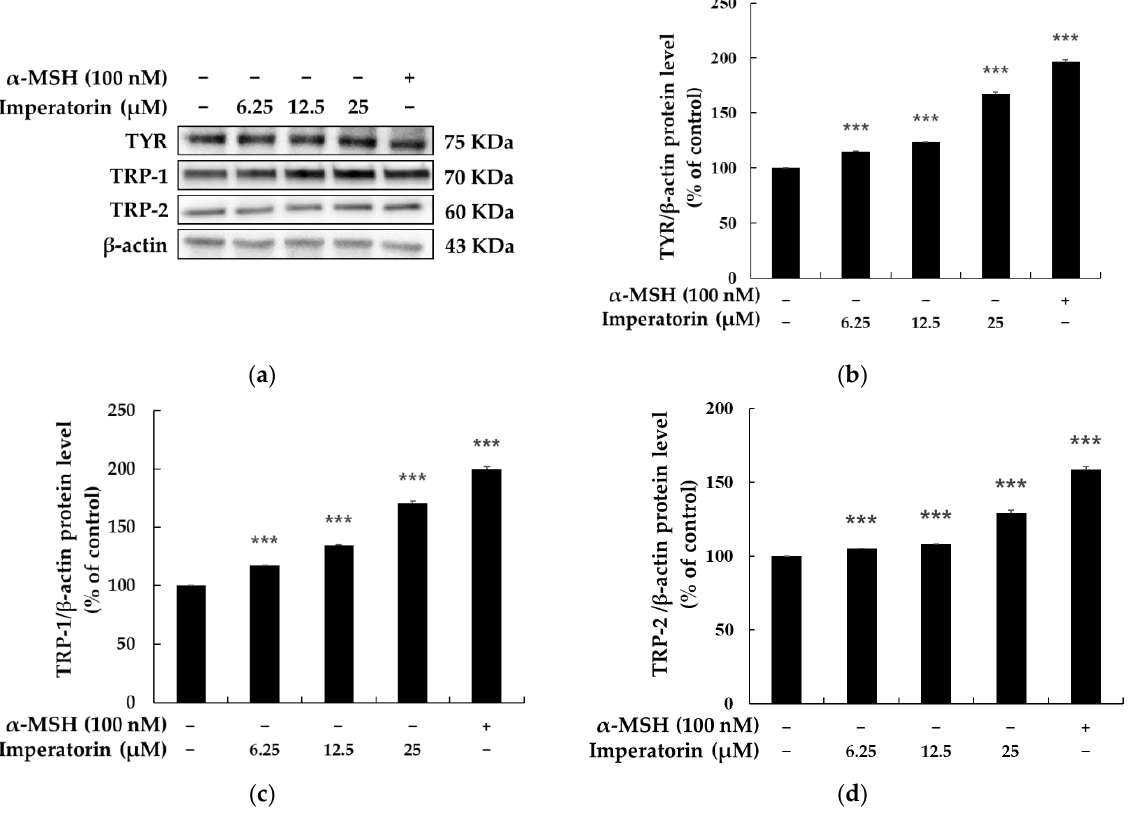
Figure 3. The effects on the protein expression of TYR, TYRP-1, and TYRP-2 in B16F10 melanoma cells when the cells were treated with imperatorin (25, 12.5, and 6.25 μM) for 48 h: ( a ) Western blotting results; protein levels of ( b ) TYR, ( c ) TYRP-1, and ( d ) TYRP-2. β -Actin was used as a loading control. The results are presented as the mean ± SD from three independent measurements using ImageJ software. *** p < 0.001 vs. the untreated control group.